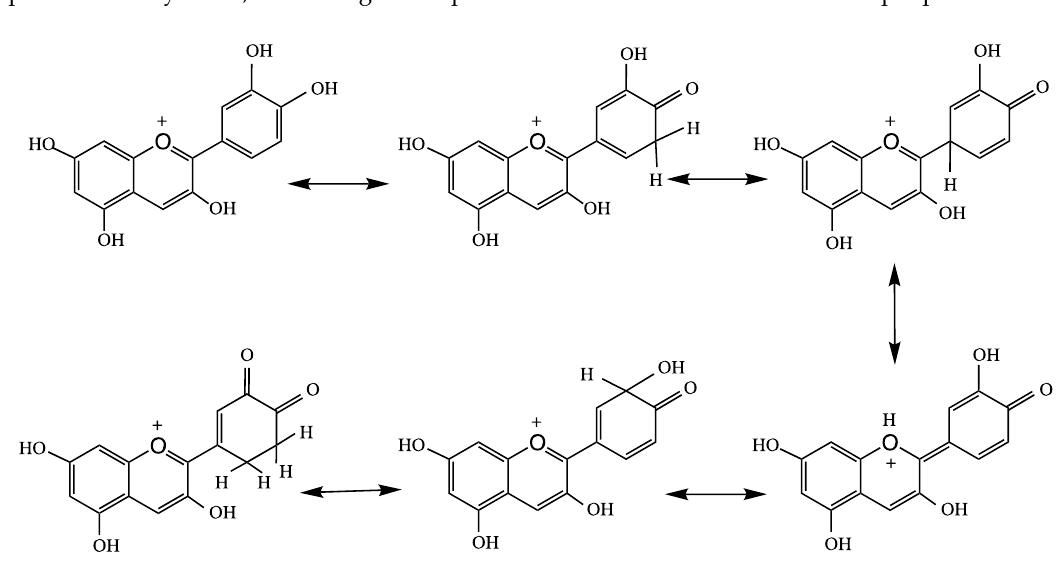
Figure 4. Quinonoid structures stabilize anthocyanidins.